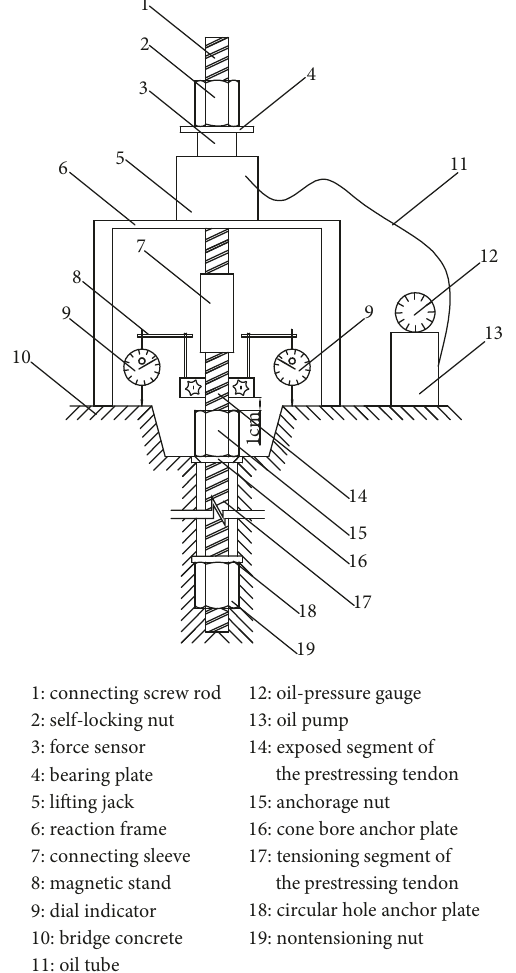
Figure 7: Schematic view of the tension technology, retraction loss, and tension measurement